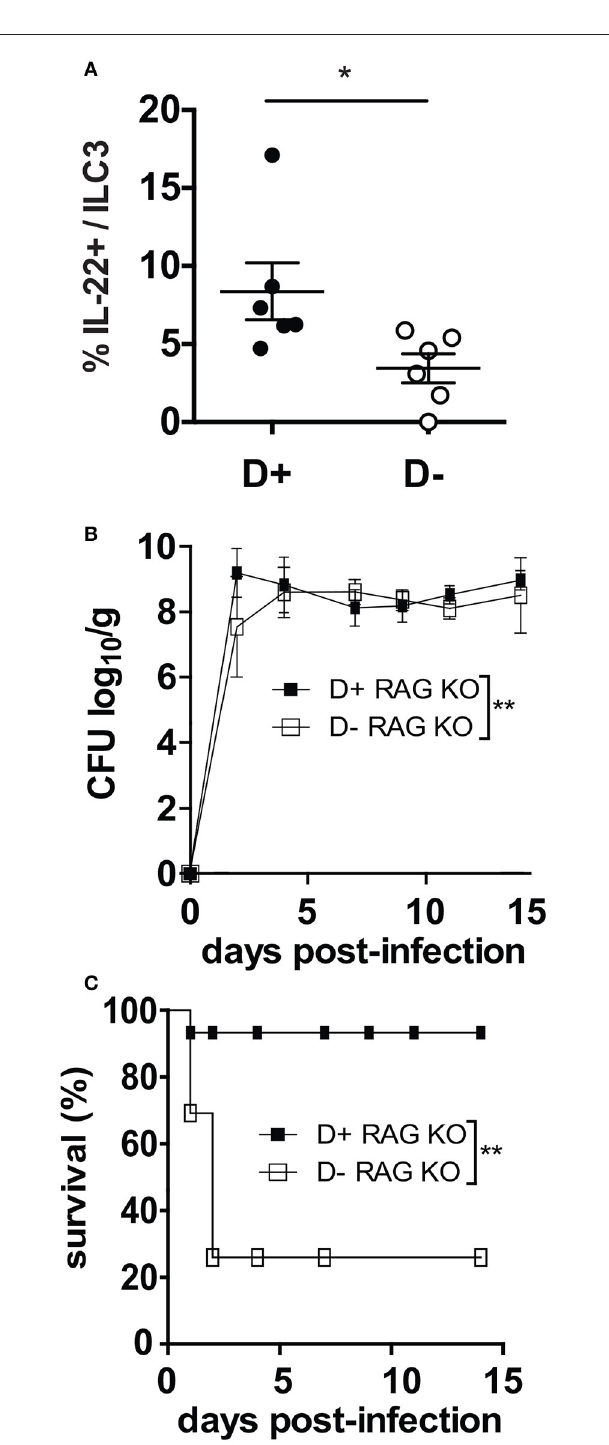
FIGURE 5 | D- Rag KO mice develop a severe and lethal C. rodentium infection. (A) IL-22 secreting ILC3 frequencies in the colon of D- and D + Rag KO mice. (B) C. rodentium fecal shedding in D + and D- Rag KO mice. (C) Survival curves following C. rodentium infection of D + and D- Rag KO mice. Values are from n = 6–7 D + Rag KO and n = 6 D- Rag KO mice of two combined experiments. Significance was determined by two-tailed Student’s t tests (A) , two-way ANOVA with Bonferroni post-hoc tests (B) or log rank tests for (C) , * P < 0.05, ** P <